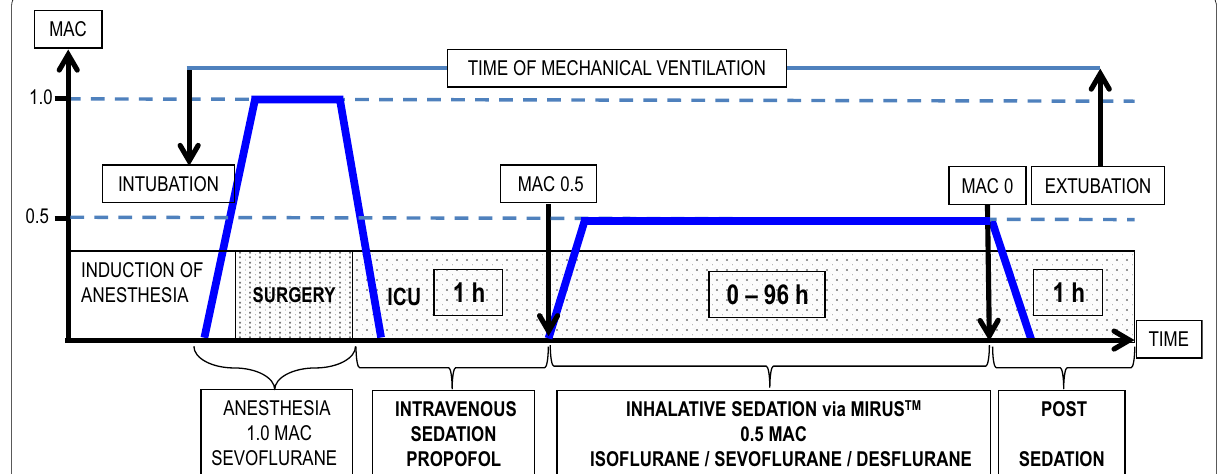
Fig. 1 Study design. After intravenous induction of anesthesia in the operating room, patients obtained a balanced anesthesia with sufentanil and sevoflurane at 1.0 MAC via a standard anesthetic machine during surgery. At the end of surgery, sedation was switched to an intravenous regime with propofol for the transport from the operating room to the intensive care unit (ICU). After a minimum of 1‑h intravenous sedation in the ICU, patients obtained isoflurane, sevoflurane, or desflurane at 0.5 MAC via MIRUS ™ . As soon as the criteria for a wake‑up test were met, a spontaneous breathing trail was performed. Once patients passed the test the MAC was set to 0. The dark blue lines mark the course of the MAC throughout the